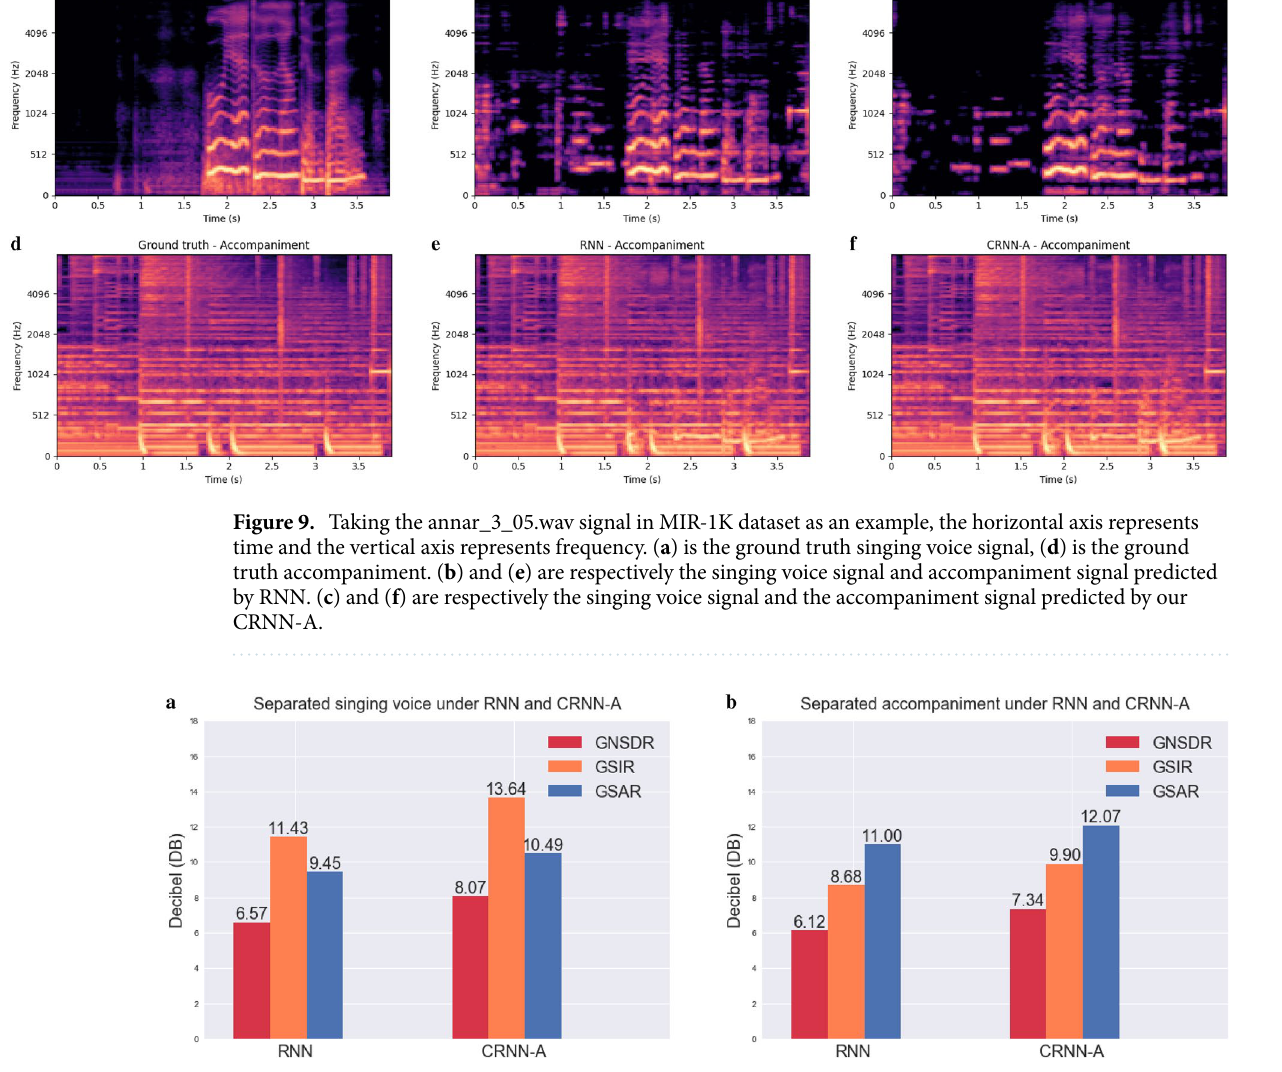
Figure 10. The GNSDR, GSIR and GSAR values on the test set of the MIR-1K dataset under the RNN and our